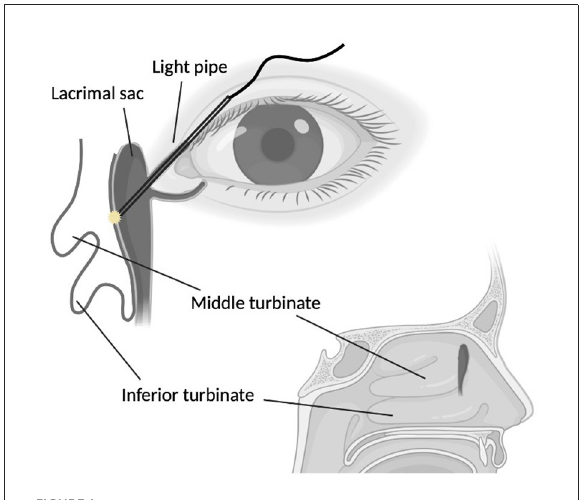
FIGURE1 Intraoperative endoscopic dacryocystorhinostomy. The light pipe was inserted from the upper canaliculus into the lacrimal sac. The illumination of lacrimal sac located in front of the middle